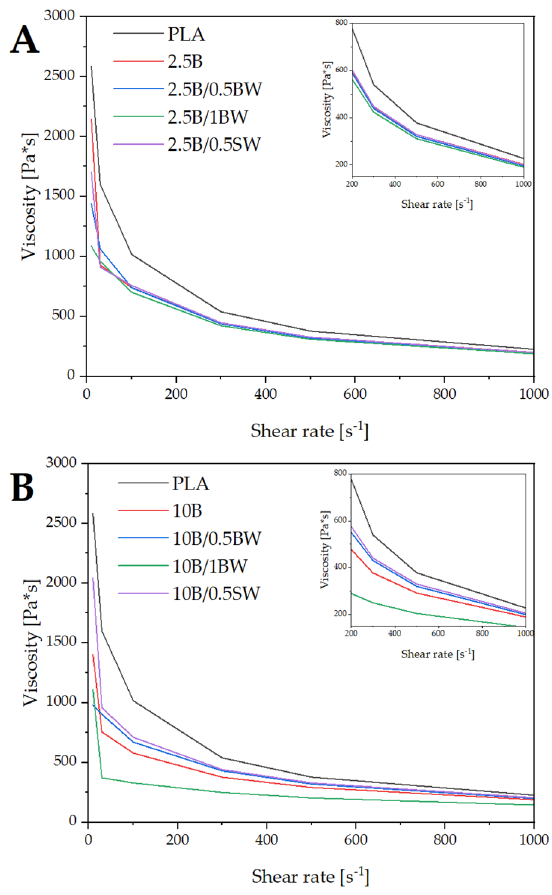
Figure 5. Viscosity of composites after injection moulding; ( A ) composites with 2.5% DE, ( B ) composites with 10% DE.